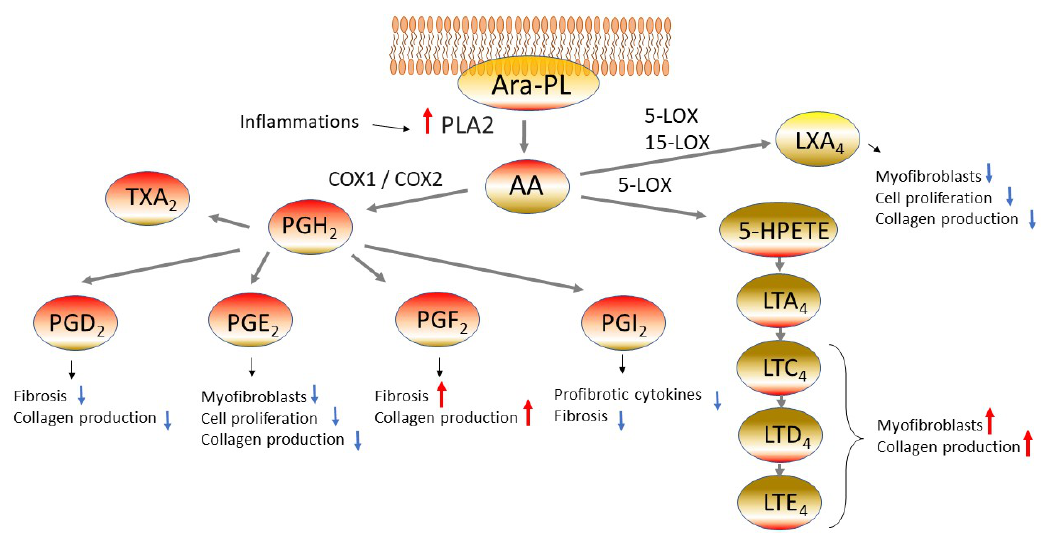
Figure 1. Eicosanoids pathway in fibrotic lung diseases. Arachidonic acid (AA) is freed from arachidonic acid esterified phospholipid (Ara-PL) by phospholipaseA2 (PLA2). AA is metabolized by cyclooxygenase-1 or -2 (COX1 or COX2) or by 5-lipoxygenase (5-LOX), yielding various eicosanoids. The eicosanoids manifest diverse physiological actions related to the pathogenesis of pulmonary fibrosis. Abbreviations: prostaglandin D2 (PGD2), prostaglandin H2 (PGH2), prostaglandin F2 (PGF2), prostaglandin I2 (PGI2, prostacyclin), thromboxane A2 (TXA2), 5-hydroxyeicosatetraenoic acids (5-HETE), leukotriene A4 (LTA4), leukotriene C4 (LTC4), leukotriene D4 (LTD4), leukotriene E4 (LTE4), lipoxin A4 (LXA4).